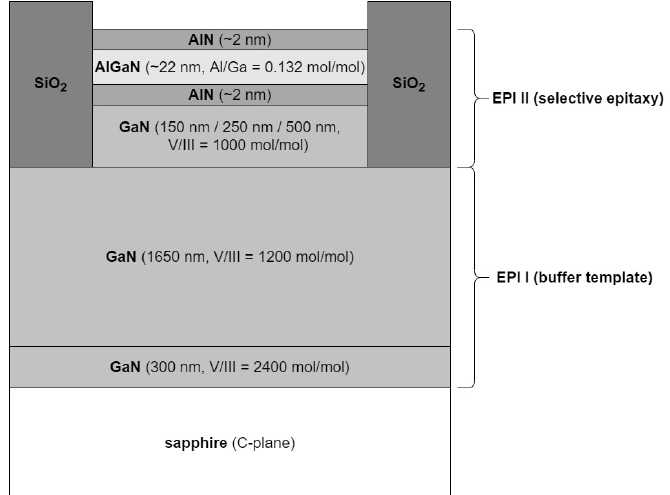
Figure 1. Layer scheme of the investigated structures.